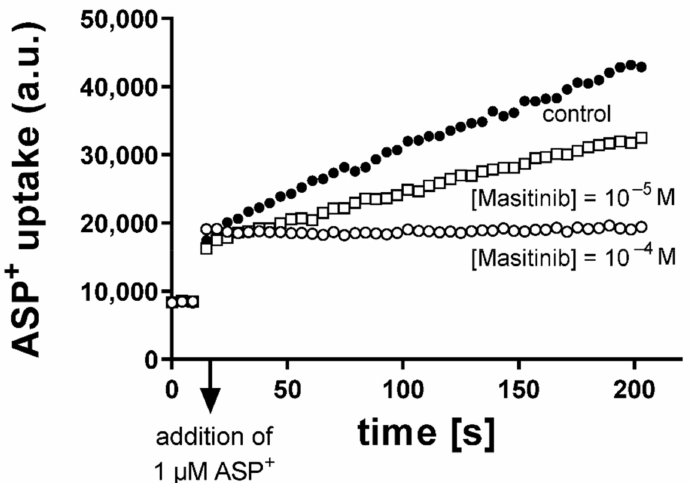
Figure 6. Example of experiments, where the uptake of 1 µ M ASP + (in arbitrary units, a.u.) over time by hOCT3-transfected HEK293 cells was measured. The uptake of ASP + alone (control, closed dots) or in the presence of Masitinib at concentrations of 10 − 5 M (open squares) or 10 − 4 M (open dots) over time is shown. A concentration of 10 − 4 M Masitinib inhibited ASP + uptake almost completely. The arrow shows the time point of ASP +